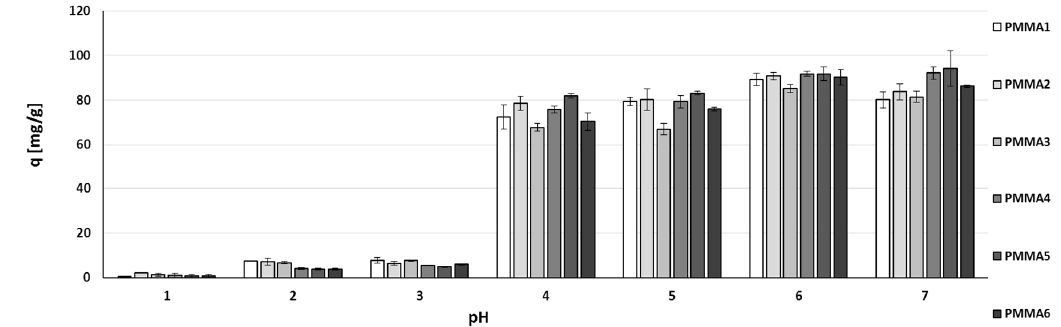
Figure 3. Comparison of sorption capacity of zinc ions at various pH values (1–7) on PMMA—based sorbents. Mass of sorbent 0.01 g, initial concentration of metal: c = 30 mg/L, volume of solution: 0.05 L, pH = 6, temperature 22 ± 1 °C, time of contact 24 h.